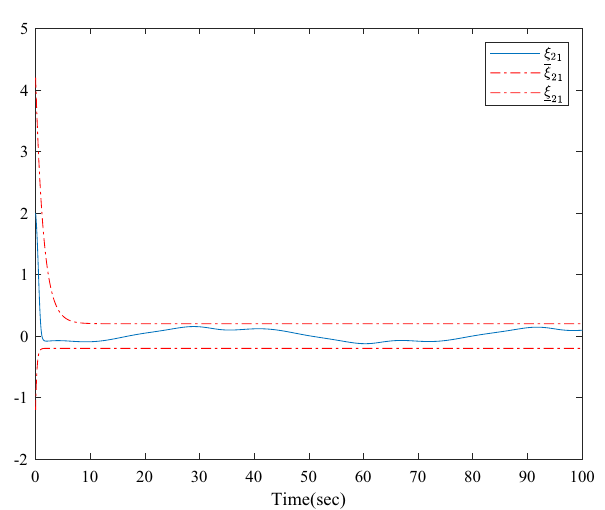
Figure 6. Error states of the following agents ξ 21 along with their